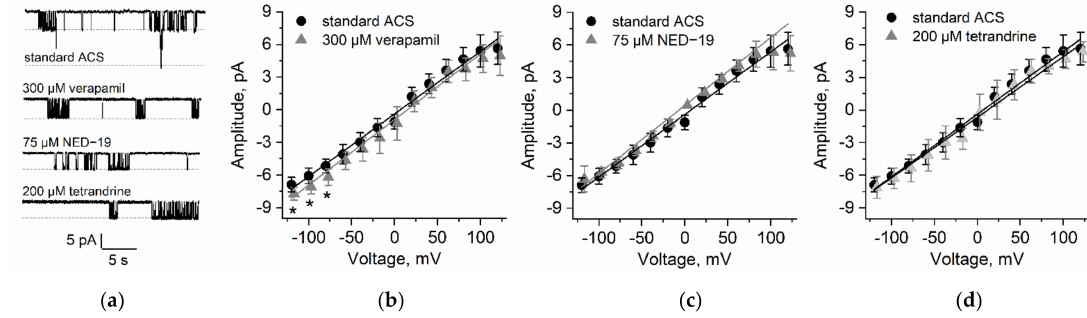
Figure 3. Comparison of high-conductance K + -permeable channel activity in the tonoplast of N. obtusa in the control solution ACS and after application of 300 µ M verapamil, 75 µ M NED-19, and 200 µ M tetrandrine. ( a ) Examples of current traces obtained at − 80 mV. Dashed lines indicate open states. The measurements were prepared in the tonoplast-attached configuration. Single channel I/V curves obtained after exposure to 300 µ M verapamil ( b ), 75 µ M NED-19 ( c ), and 200 µ M tetrandrine ( d ). Asterisks indicate significant differences, n = 5 −